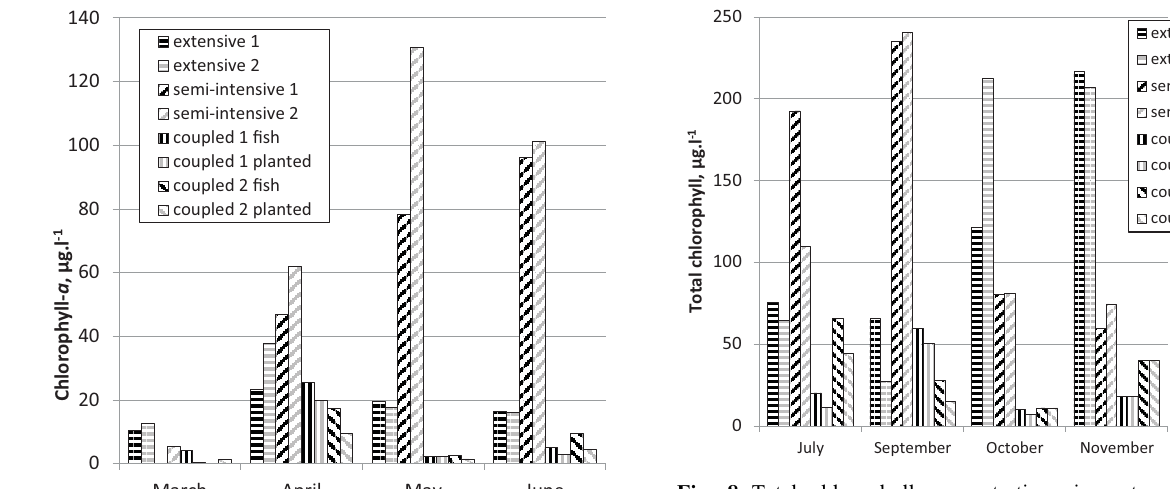
Fig. 8. Total chlorophyll concentrations in water from July to November 2014 in each Fig. 7. Chlorophyll-a concentration in water from March to June 2014 in each pond. Table 5. Total nitrogen (TN) and phosphorus (TP) contents in the sediment (mg · g (cid:3) 1 dry sediment) of each pond at fi sh stocking and harvest. TN TP